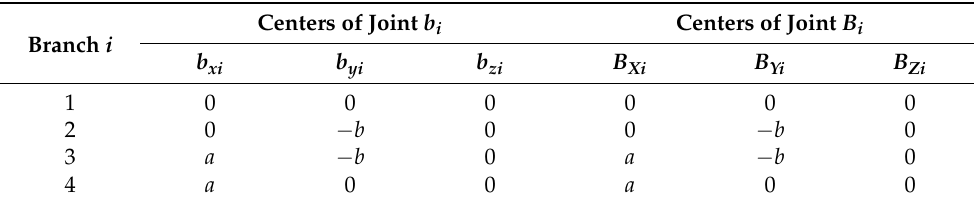
Table 1. Position of